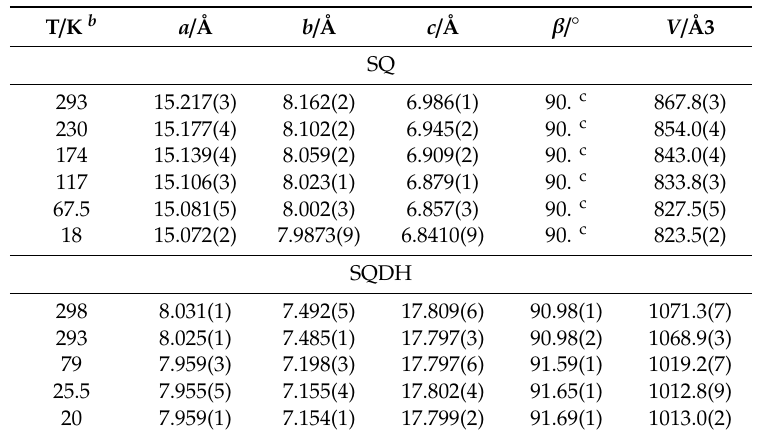
Table 1. Cell dimensions a of SQ and SQDH.